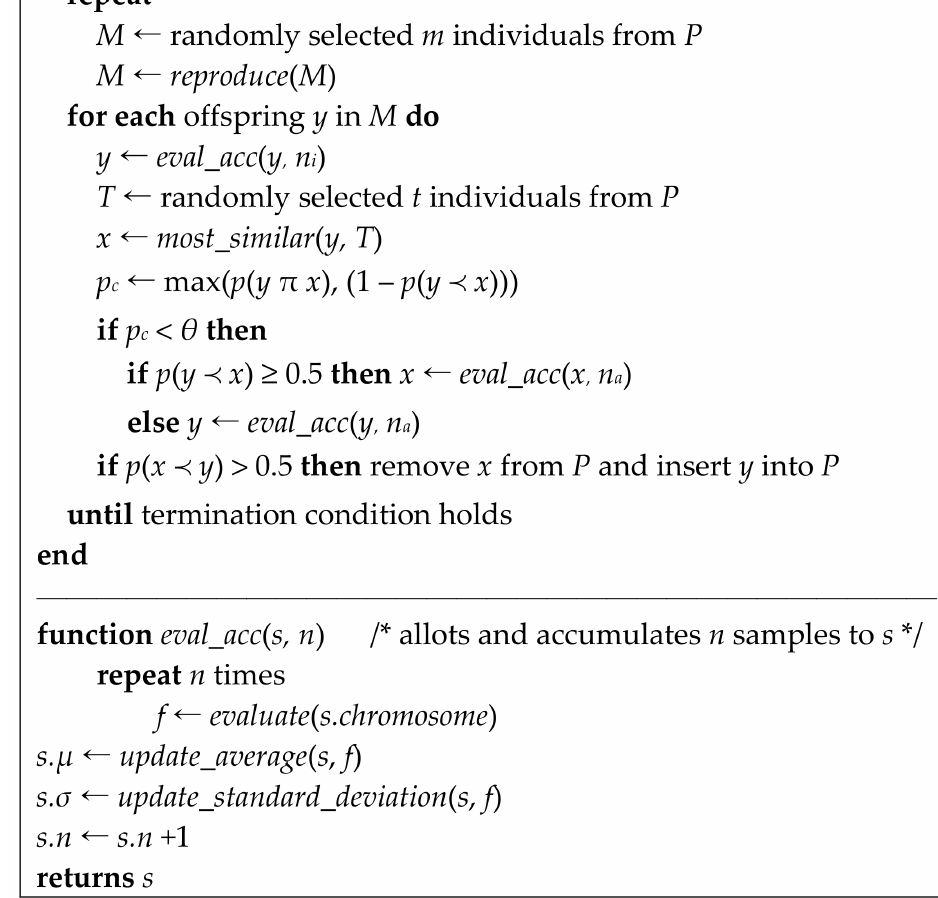
Figure 6. Pseudocode of